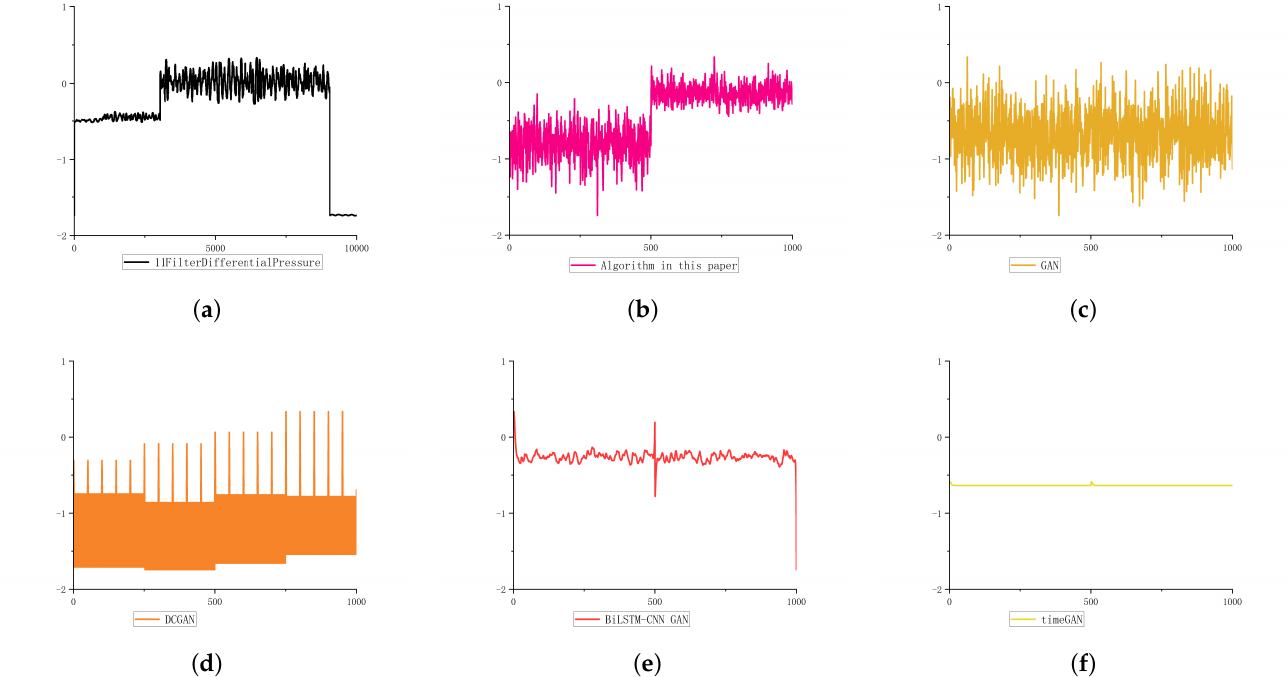
Figure 7. ( a ) Original data of 11filterdifferentialpressure feature of the real underlying business dataset of the oil depot; ( b ) generation results of the algorithm in this paper; ( c ) generation results of GAN; ( d ) generation results of DCGAN; ( e ) generation results of BiLSTM-CNNGAN; ( f ) generation results of